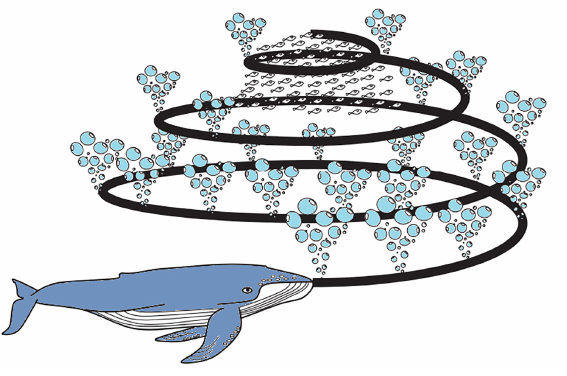
Figure 8. Humpback whale hunting